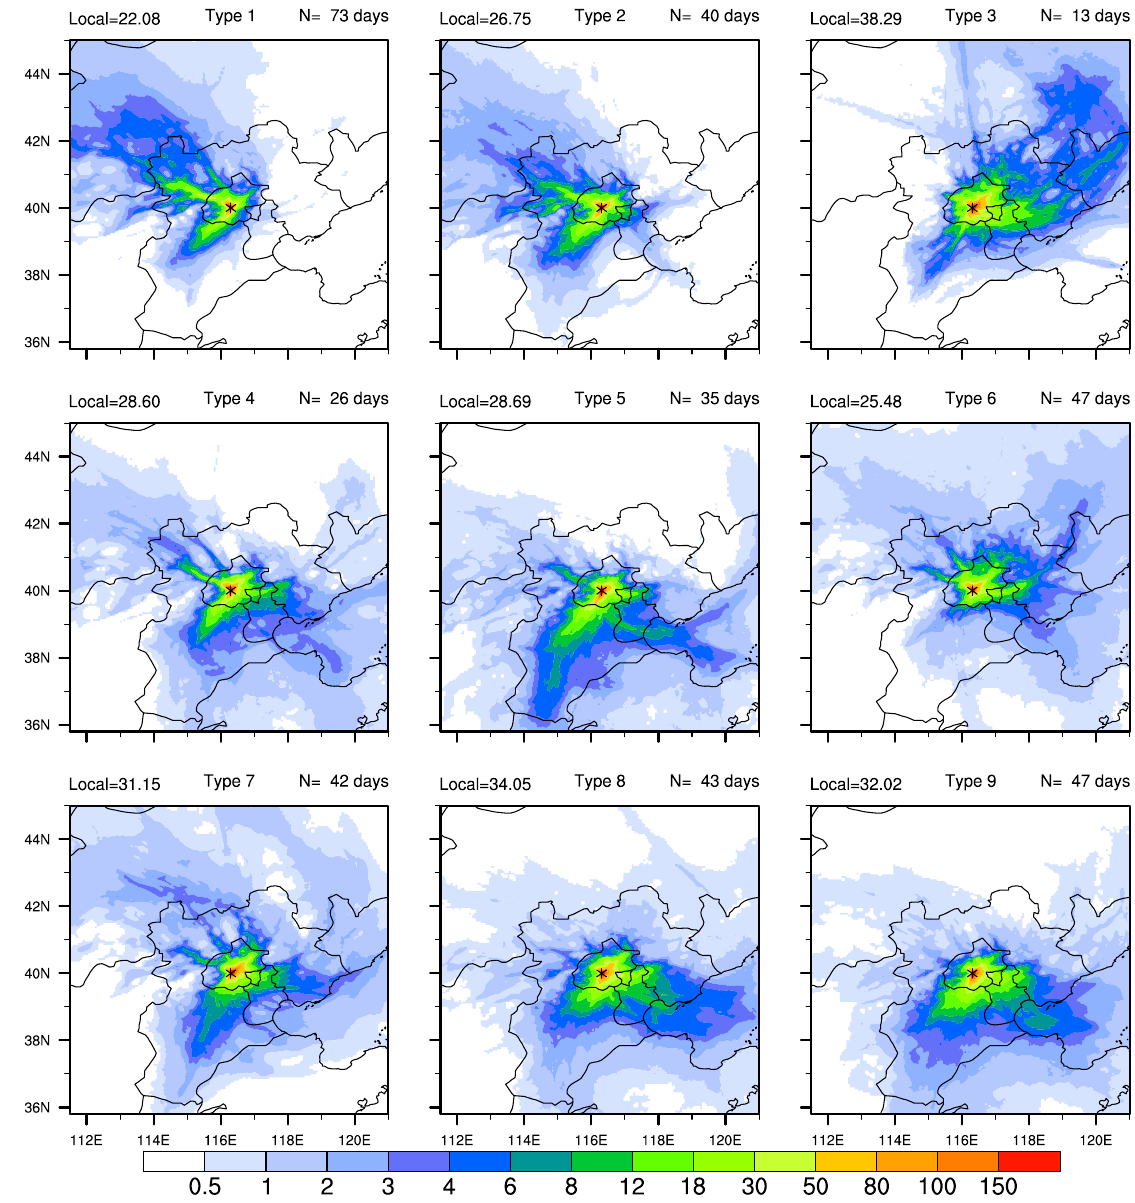
Fig. 5. Averaged footprints (residence times of 48-h backward trajectories) for each circulation type during the period June 2008 to May 2009. The markers denote the location of the PKU